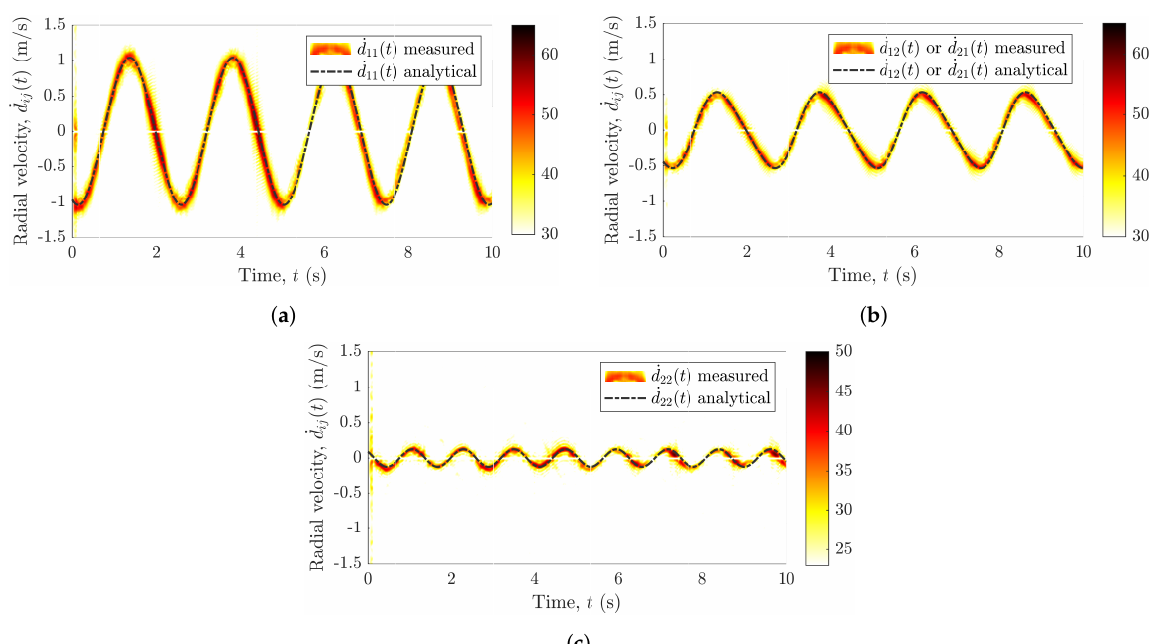
Figure 6. Application of the proposed interference mitigation scheme results in segregated measured radial velocity components ˙ d ij ( t ) for the channel links: ( a ) A T x